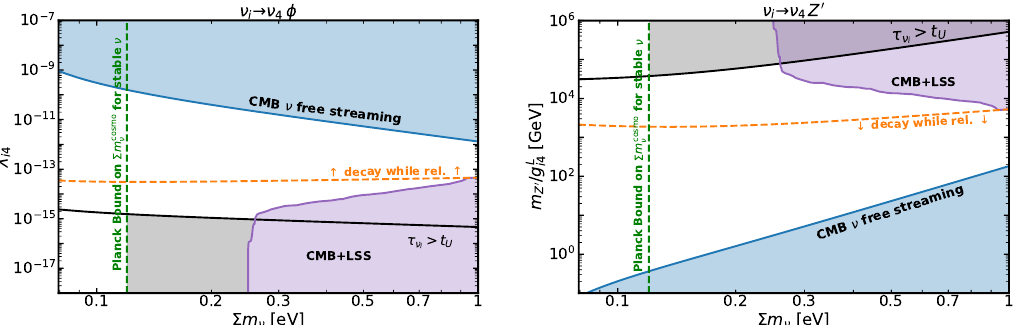
Figure 6 . Parameter space for case 2s (see figure 1). Left panel: parameter space for ν i → ν 4 φ decays. Right panel: parameter space for ν i → ν 4 Z 0 decays. Both correspond to the 2s case in figure 1. We have chosen m φ,Z 0 (cid:28) m ν . For ν i → ν 4 φ we consider only pseudo-scalar couplings but i note that the rates are identical for scalar couplings. In orange we show the line separating relativis- √ Ω m ( P m ν / (9 T ν, 0 )) 3 / 2 . tically and non-relativistically neutrino decays given by [21]: 1 /τ ν ’ H 0 The blue region is excluded by CMB constraints on relativistically decaying neutrinos [22]. The magenta region is excluded by cosmological bounds on non-relativistically decaying neutrinos [21]. The Planck bound on P m ν extracted within Λ CDM is indicated by the dashed green line. The constraint from [21] does not saturate the Planck bound for τ ν (cid:29) t U simply because different data sets were considered in the analysis of